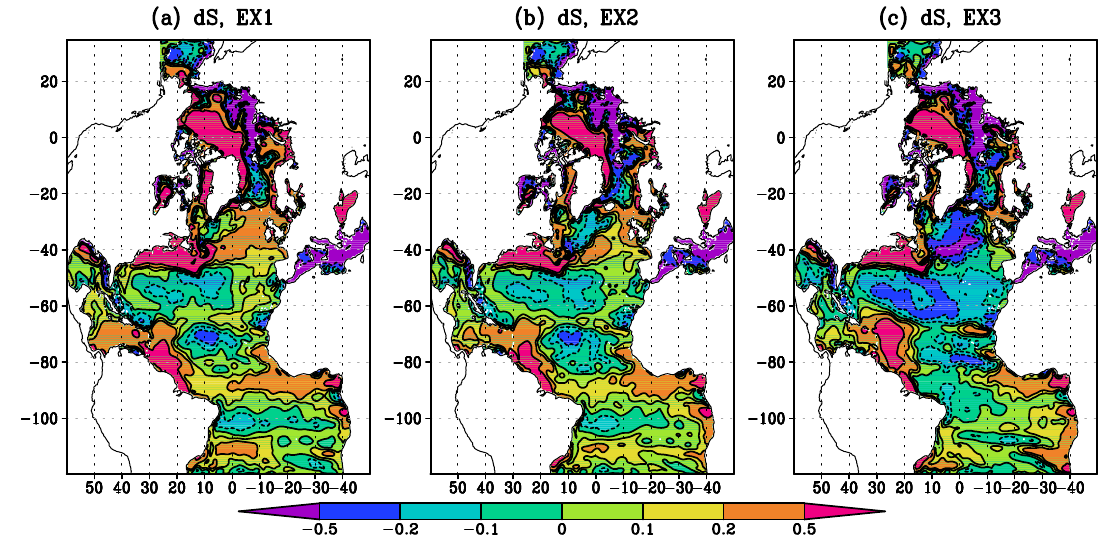
Figure 2. Average for 1963–2009 deviation of salinity (in PSU) in the 0–30 m layer from the climatic observational data [42] in the experiments EX1 ( a ), EX2 ( b ) and EX3 ( c ). The model coordinates are used (see the caption under Figure